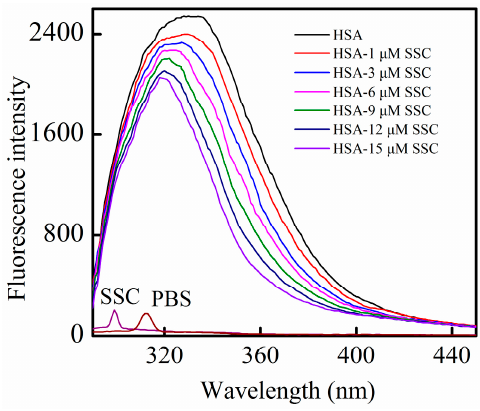
Figure 2. Fluorescence quenching of HSA in the presence of SSC. The observations were performed at 26 °C. λ ex = 280 nm; C HSA = 2 μ M; SSC, saikosaponin C.